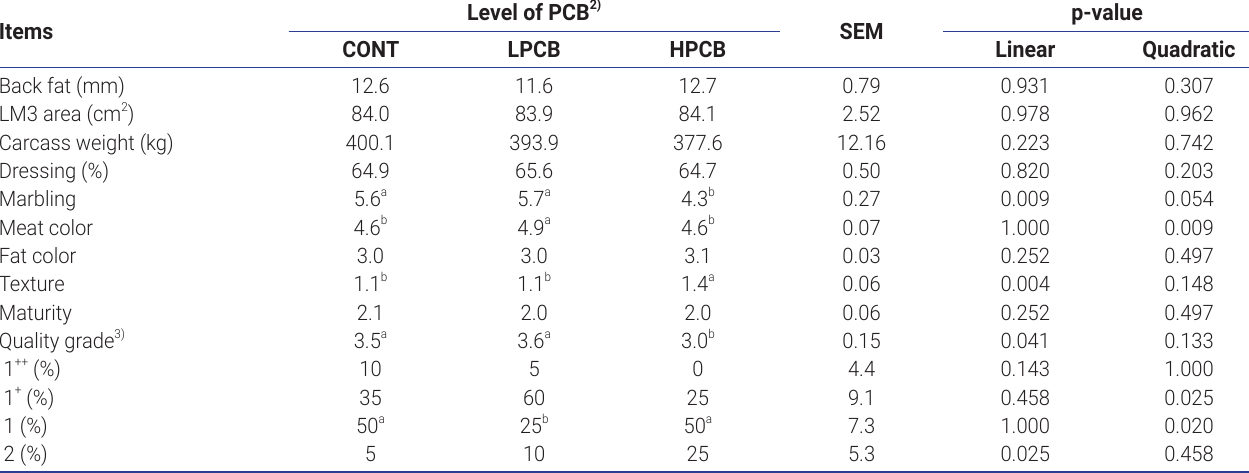
Table 5. Effects of pineapple cannery by-product on carcass traits of finishing Hanwoo steers 1)